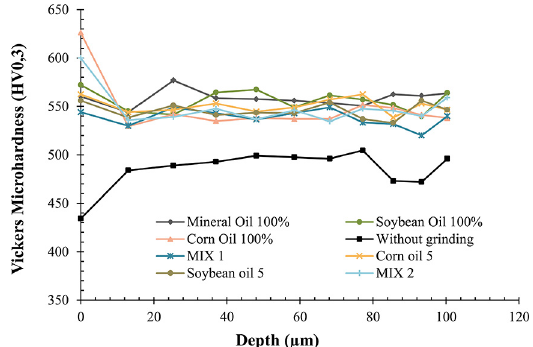
Figure 5. Micrographs of samples grinded with Corn pure (A) and Corn 5 (B).